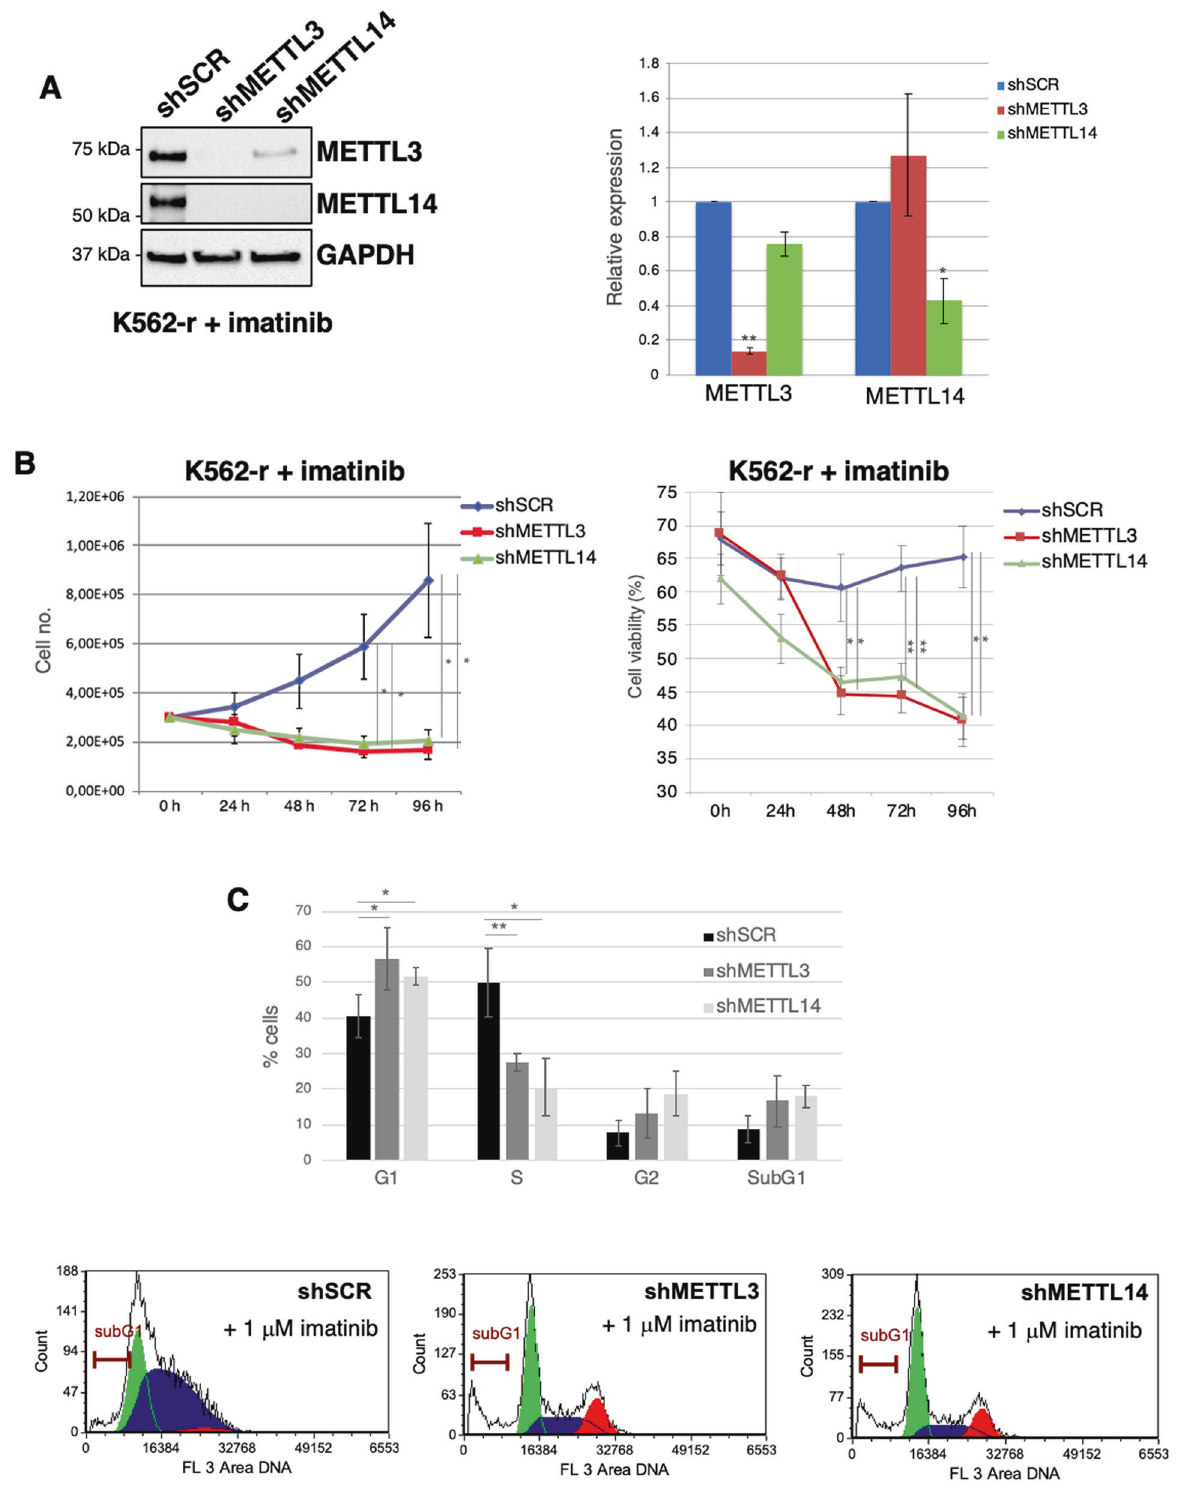
Fig. 3 METTL3 and METTL14 knockdown affects imatinib-resistant K562 cells proliferation. A Western blot analysis in shMETTL3, shMETTL14 and shSCR K562-r transduced cells. Protein levels were analyzed 48 h after puromycin selection. B Growth curve (left panel) and percentage of cell viability (right panel) of shSCR, shMETTL3 and shMETTL14 K562-r infected cells after puromycin selection, n = 5. C Upper panel, the histogram represents the cell cycle distribution of cells analyzed 48 h after puromycin selection, n = 3. Lower panel, representative cell cycle analysis. The ratio of each sample versus its experimental control was tested by two-tailed Student ’ s t- test. * p < 0.05, ** p < 0.01.